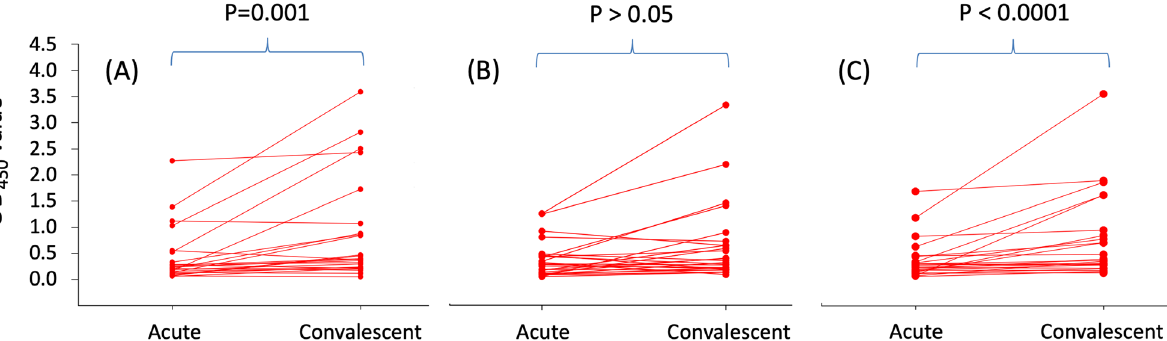
Figure 2. Differences in absorbance values obtained from Rec-ELISA using ( A ) rMLD, ( B ) rNP, and ( C ) rNP/ rMLD probed with the consecutive sera collected from CCHF patients during acute (1–7 days) and convalescent (8–25 days) phase (n: 25). Acute vs. convalescent median (IQR) absorbance value [optical density (OD)] of Rec-ELISAs using ( A ) rMLD was 0.21 (0.13–0.43) vs. 0.39 (0.22–0.98) with a P = 0.001, ( B ) rNP, 0.34 (0.14–0.52) vs. 0.42 (0.24–0.77); P > 0.05, and ( C ) rNP/rMLD, 0.26 (0.15–0.42) vs. 0.39 (0.27–0.94); P < 0.0001. The results were evaluated in a micro titer plate reader (Bio-Tek ELx808, USA) at 450 nm and expressed as OD. Data were analyzed by Wilcoxon signed-rank test. Cut-off values of each plate ranged between 0.140 and 0.152 (OD 450